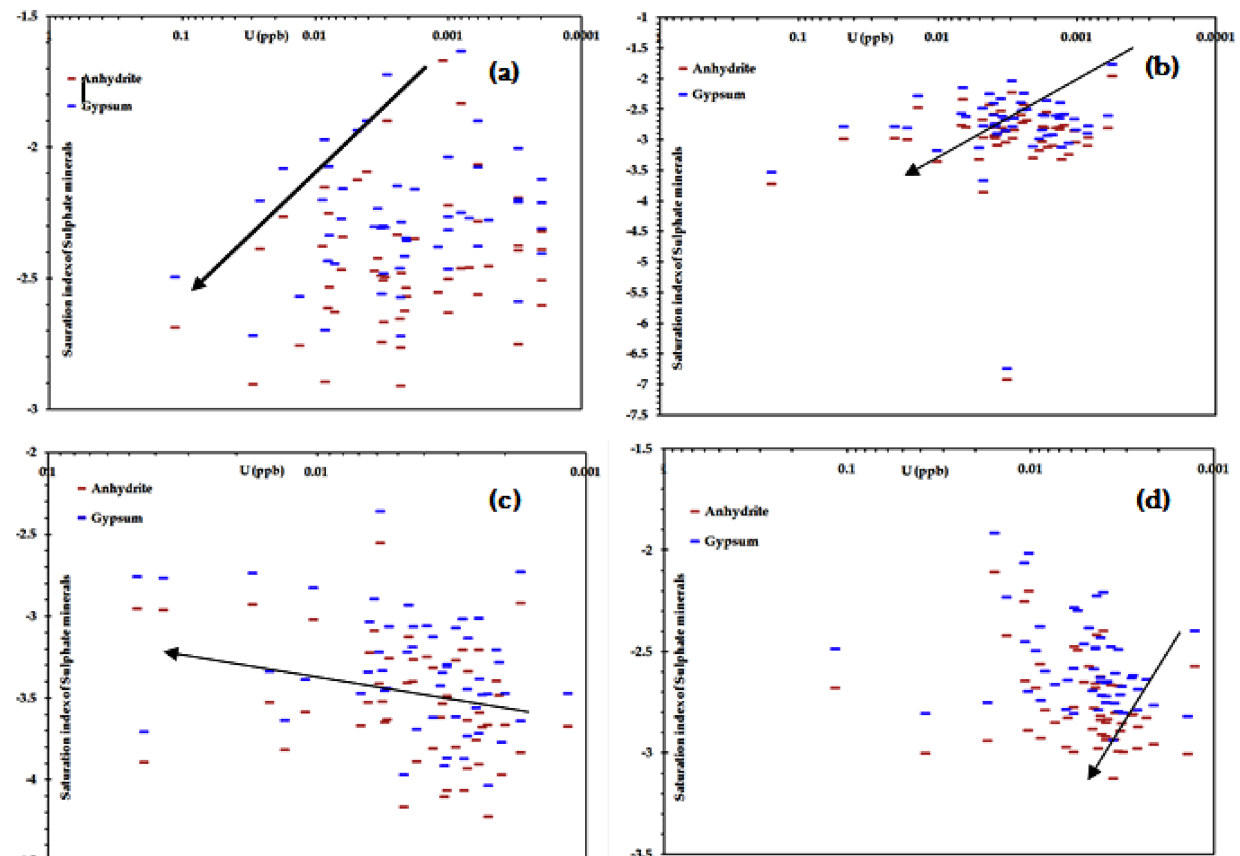
Fig. 15 Variation of Saturation index of different sulfate minerals with total uranium for samples collected during a PRM, b SWM, c NEM, d